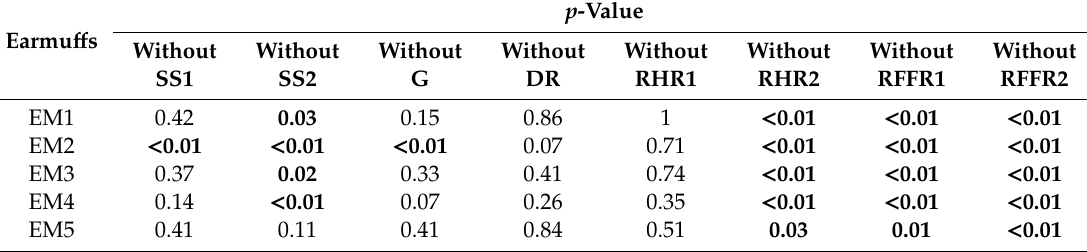
Table 2. p -values determined for comparison of SPLs under the earmu ff s used without OPPE and with OPPE. EM—earmu ff s, SS—safety spectacles, G—goggles, DR—disposable respirator,